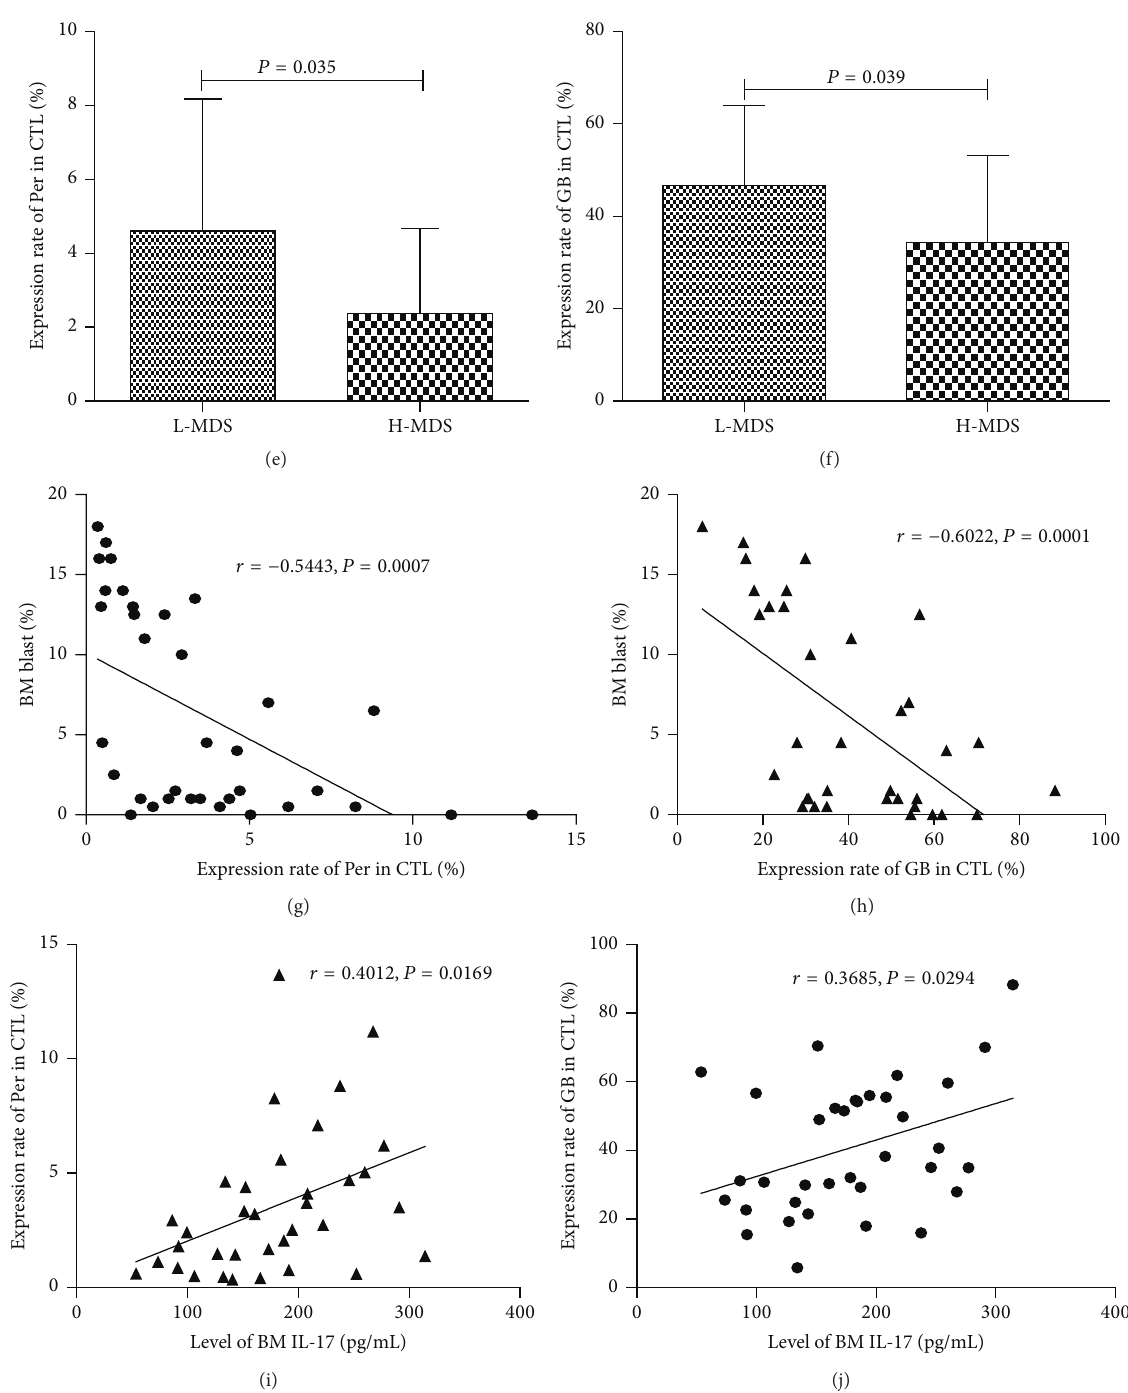
Figure 6: Correlations of Per as well as GB expressed in CTL and IL-17. Lymphocytes were gated by flow cytometry (a). Representative FACS dot plots of Per+ and GB+ CTL cells before rhIL-17 stimulation (b) and after rhIL-17 stimulation (c) were shown. The CTL percentages were shown in (d); also the expression rates of Per and GB were shown in (e-f). Correlations between Per, GB expression, and bone marrow blast ratios (g-h) as well as levels of IL-17 (i-j) were